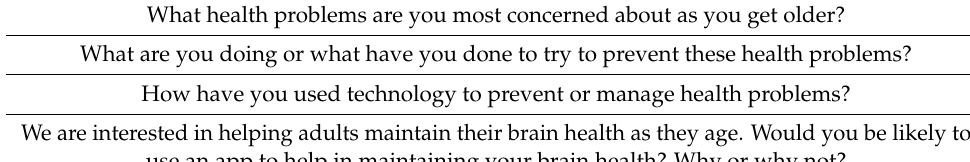
Table 1. Focus Group